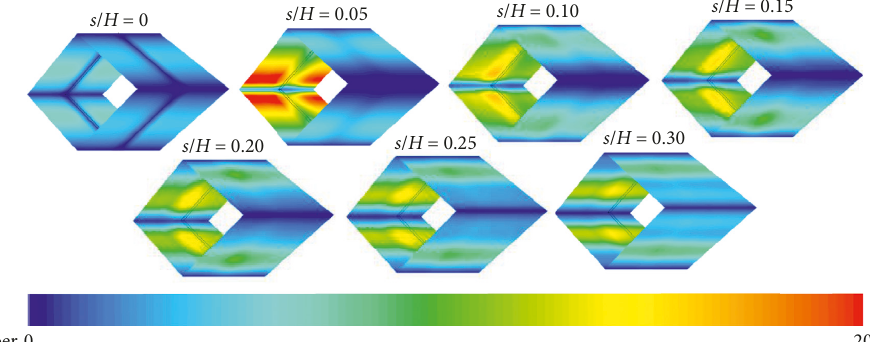
Figure 9: Nu x of the heat exchanger square duct installed with the 45